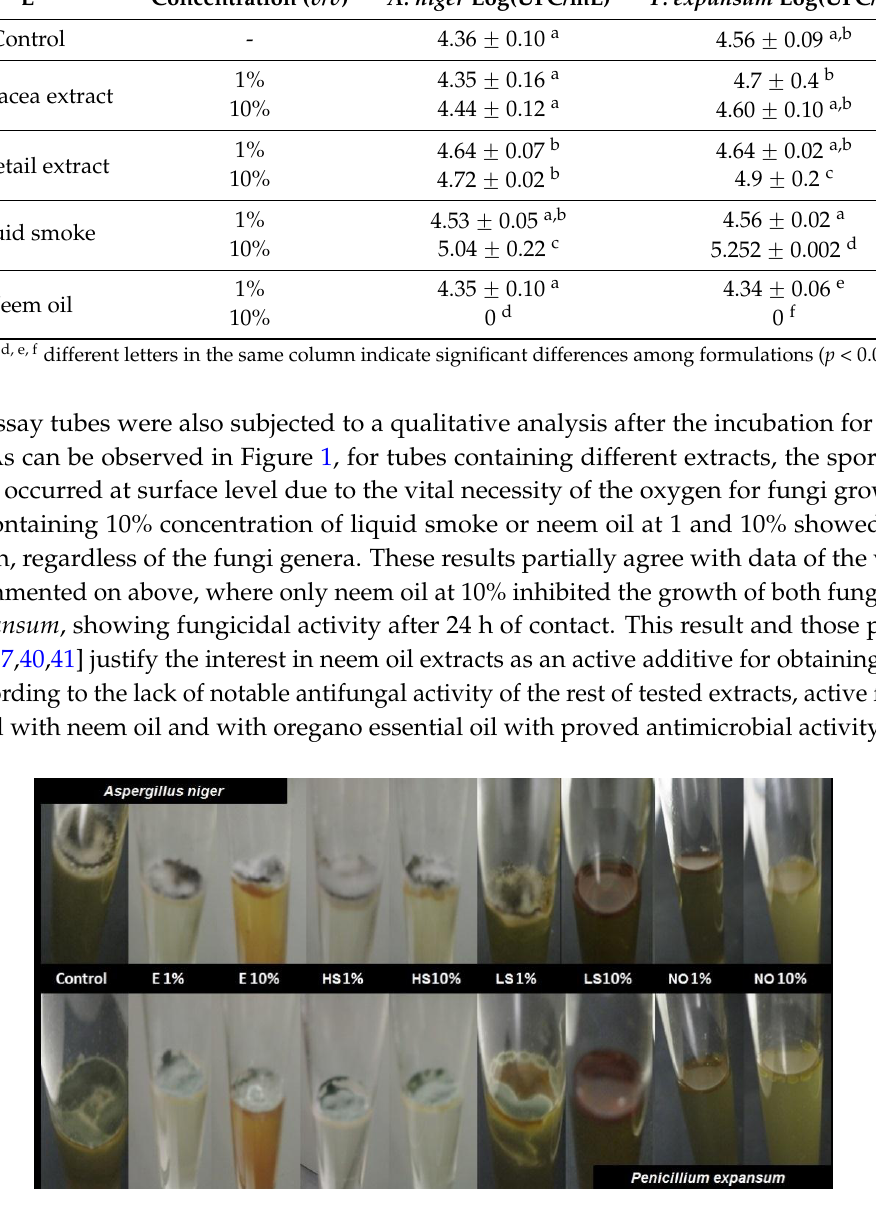
Figure 1. Photographs of natural extracts (1%wt and 10%wt) in PDB broth, inoculated with both